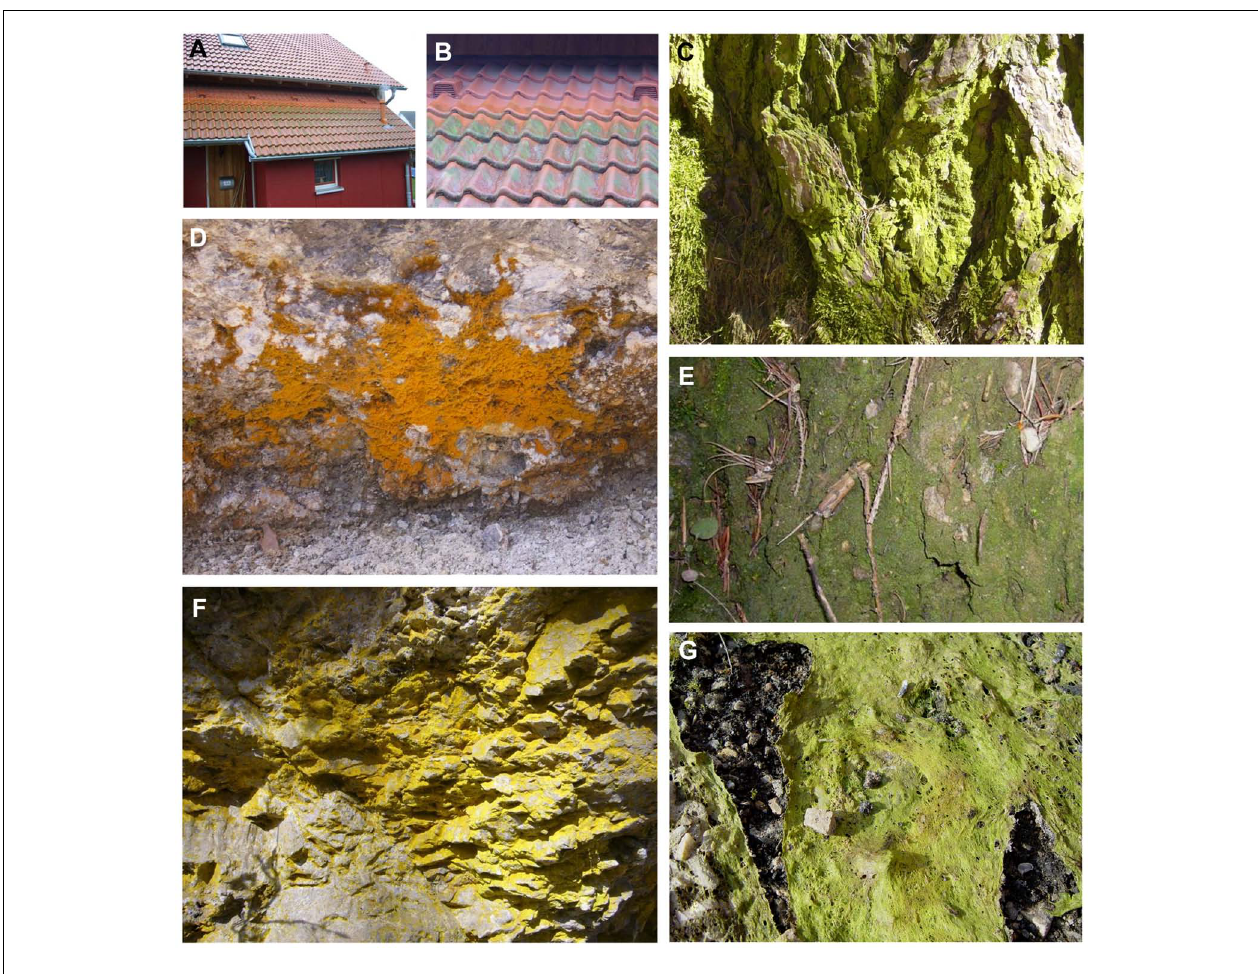
FIGURE 2 | Different habitats of desiccation-tolerant green algae, on anthropogenic (A,B) or natural (C–G) surfaces. (A) Aeroterrestrial biofilm dominated by Apatococcus sp., growing on roof tiles in Rostock, Germany, (B) detail from the same roof, note the biofilm only on the rain-exposed tiles, (C) Apatococcus sp. on bark of tree, Innsbruck,Tyrol,